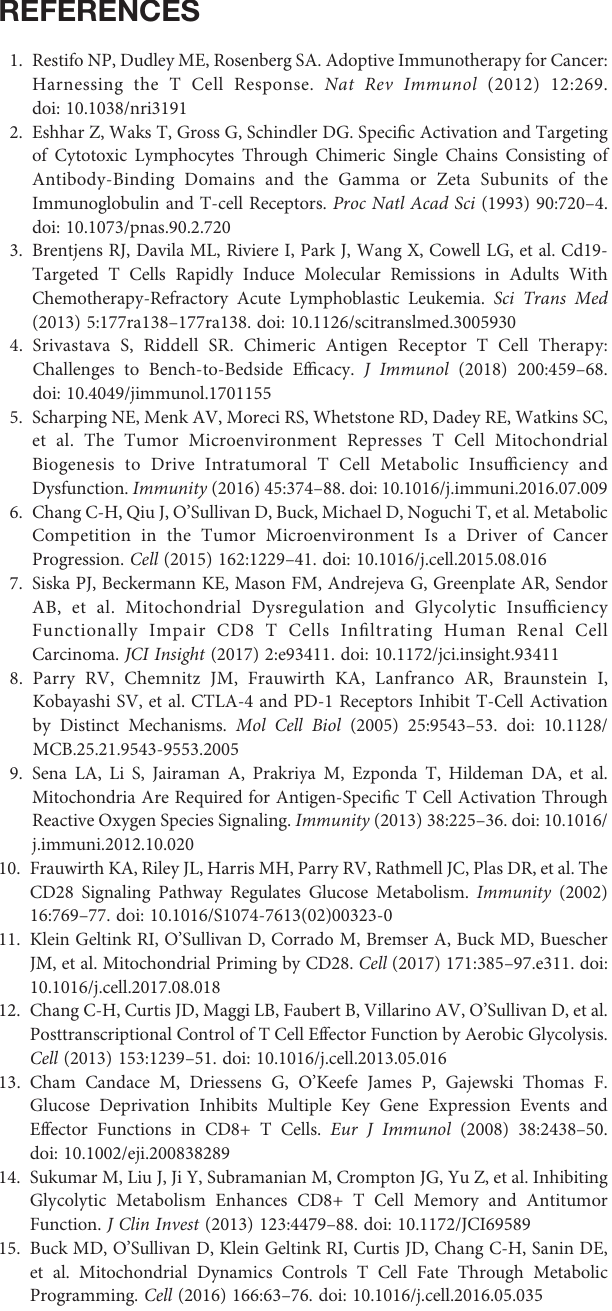
media, illuminated with 530 nm for 1 hour or kept in the dark, and then the Glucose Uptake-Glo Assay protocol was followed. Data shown as mean ± SEM and analyzed by One-Way ANOVA with a Bonferroni post-test (representative of three experiments; RLU: relative luminescence units). Movie 1 | Representative movie of CD8 + T cells expressing GFP migrating on ICAM-1 + CXCL12 with 500 nm illumination. Movie 2 | Representative movie of CD8 + T cells expressing OptoMito-On migrating on ICAM-1 + CXCL12 with 500 nm